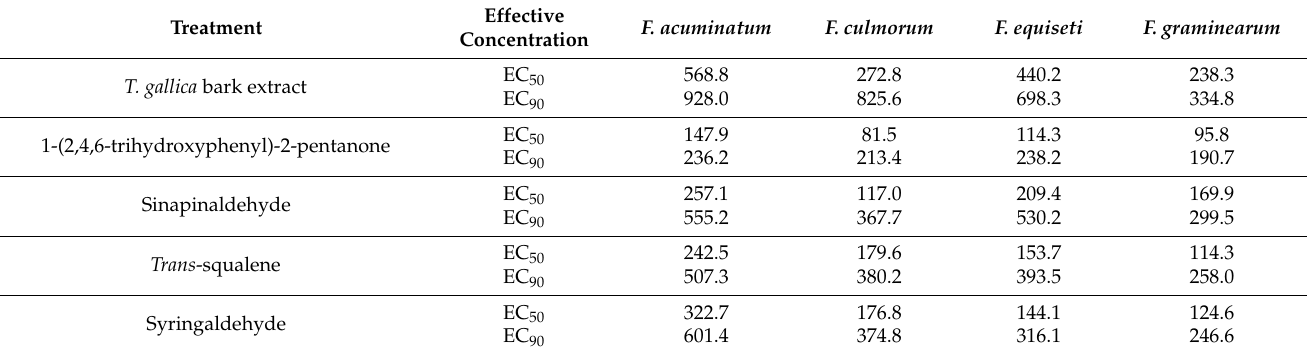
Table 3. Effective concentrations (expressed in µ g · mL − 1 ) against F. acuminatum , F. culmorum , F. equiseti , and F. graminearum of T. gallica bark aqueous ammonia extract and four of its main constituents.